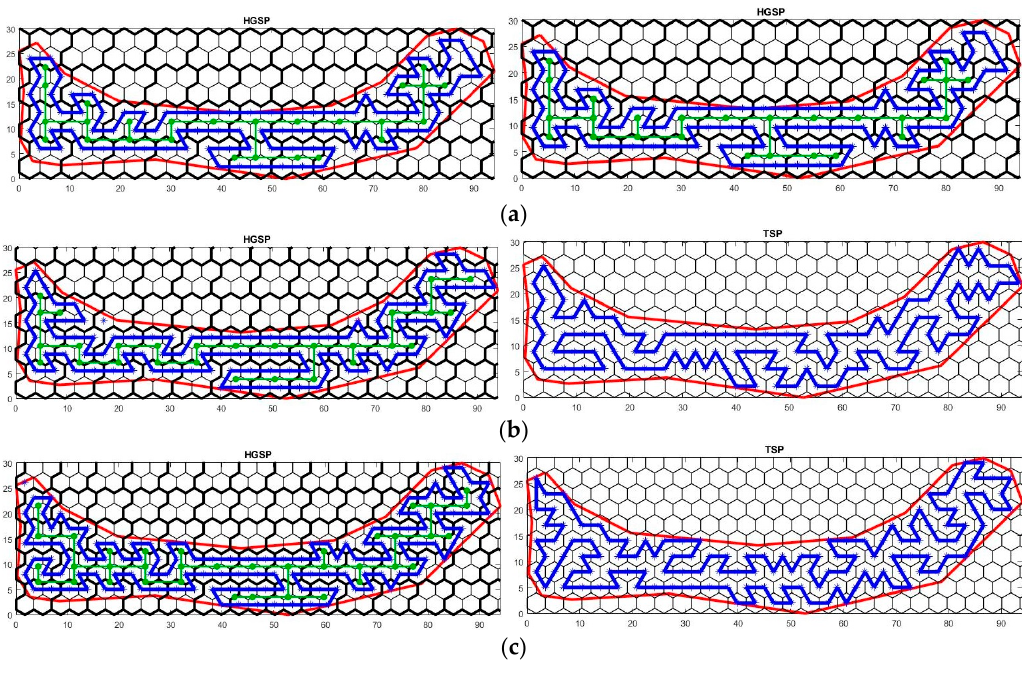
Figure 7. Generated survey plan using Hexagonal Grid-based Survey Planner (HGSP) and